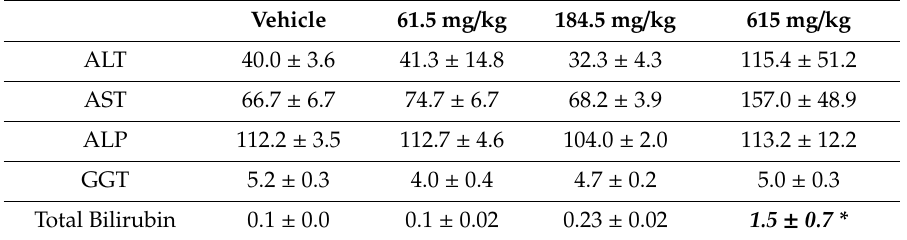
Table 2. Clinical chemistry parameters after dosing with CBD oil for two weeks. Cells in bold italics are significantly different from vehicle (One ‐ Way ANOVA, indicated by *, or Kruskal ‐ Wallis with appropriate post ‐ hoc test). Data presented as mean ± SEM ( n = 6/group).